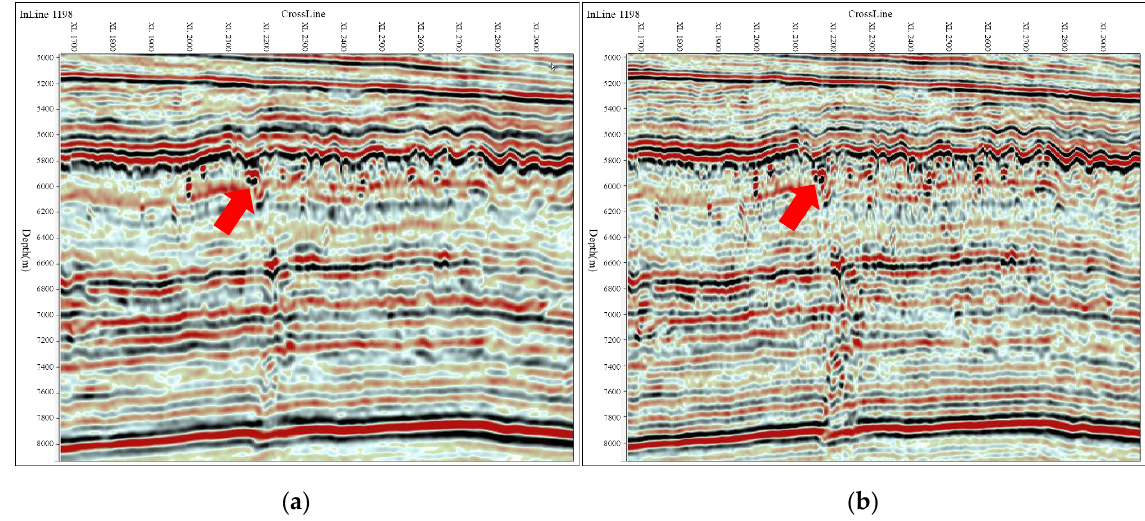
Figure 9. Comparison between migration results for CDP index of 1198. ( a ) results from RTM; ( b ) results from LSM.